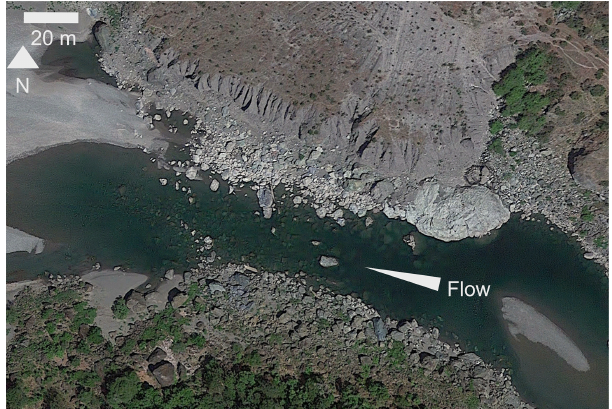
Figure 12. © Google Earth satellite image of the Eel River at the toe of the Mile 201 earthflow, 28 May 2014. Flow is from right to left, and north is up. Earthflows enter the channel here on each bank, which likely explains the different colored boulders being deposited on each bank.